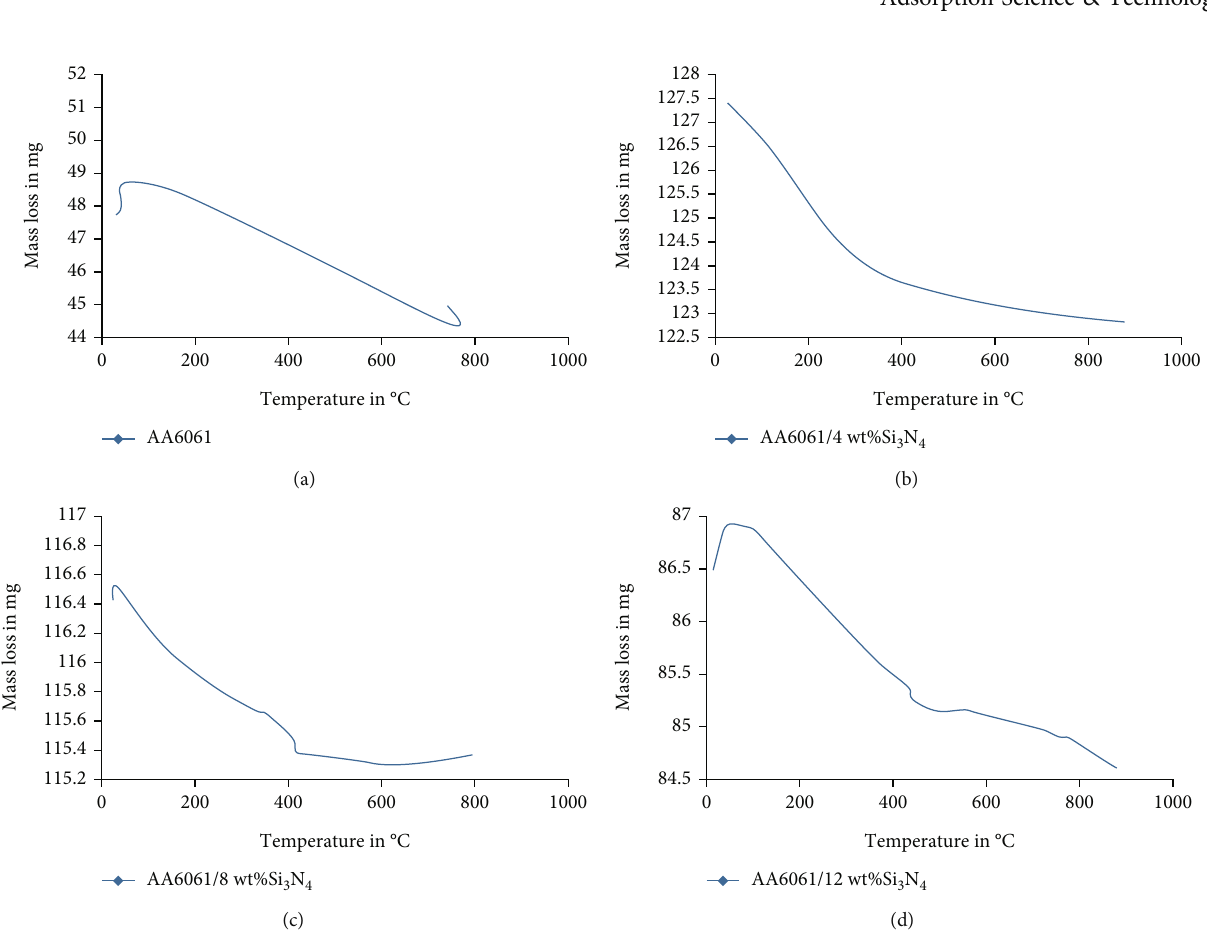
N (b) Thermogravimetric analysis for AA6061/4wt% Si 3 4.